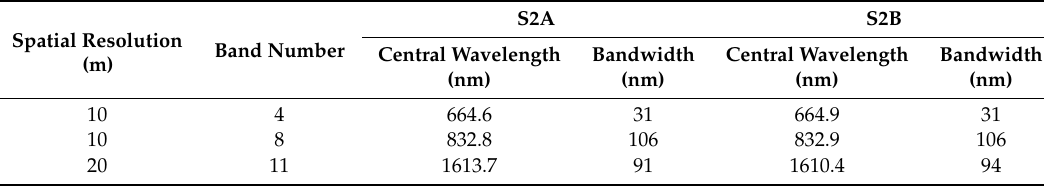
Table 1. Information of Sentinel 2A / B MSI channels used to calculate